Question: What kind of plot is shown here?
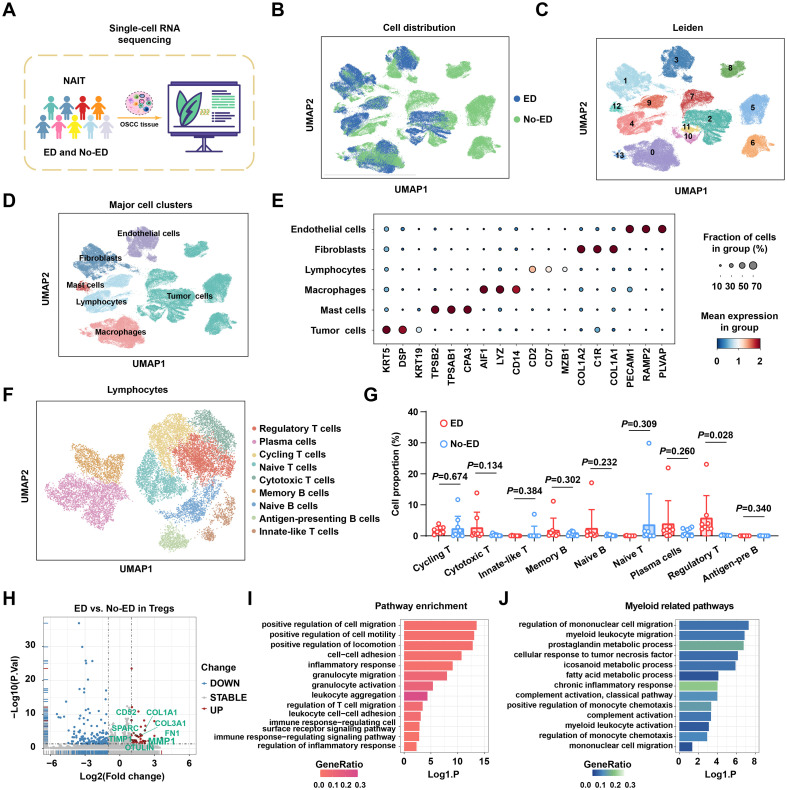
Answer: scatter